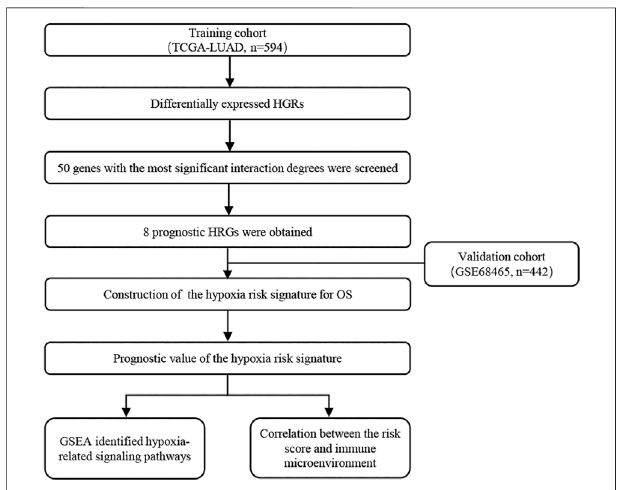
FIGURE 1 | The work fl ow of this